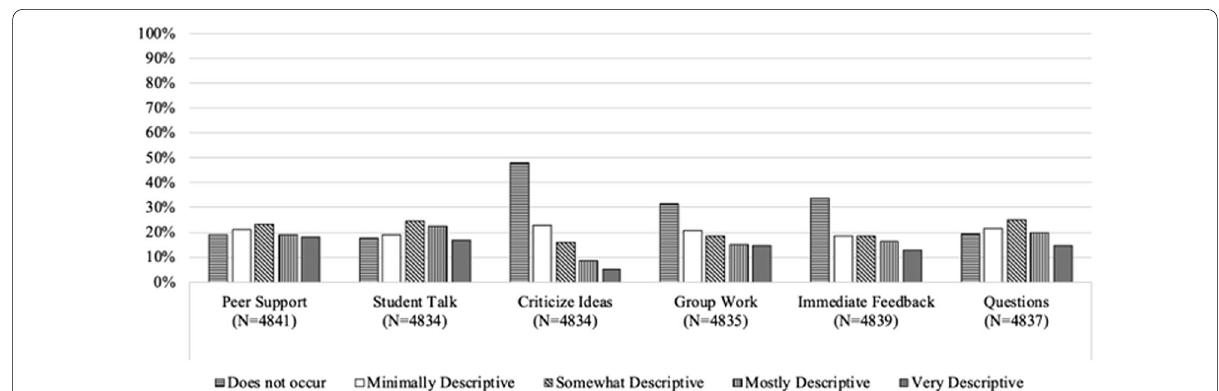
Fig. 1 Summary of descriptiveness of Interactive Classroom Characteristics